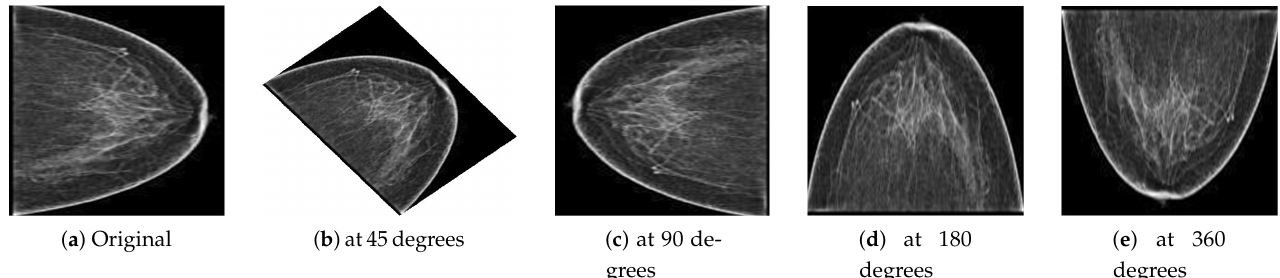
Figure 4. ( a ) Original image and the resultant images from the PINUM dataset after the augmentation steps were applied to achieve the rotated images ( b ) at 45 degrees, ( c ) at 90 degrees, ( d ) at 180 degrees, and ( e ) at 360 degrees.